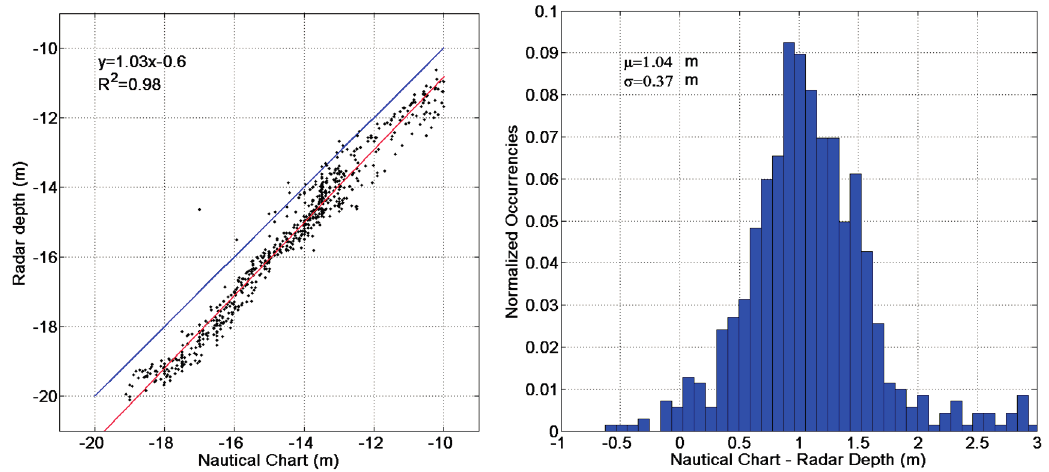
Figure 8. ( Left ) Radar depth vs. echo-sounder measurements. The red line denotes the regression line, whose equation is given in the left top side; ( Right ) Histogram of differences between the radar depth and echo-sounder measurements. The mean value (µ) and the standard deviation ( σ ) of the differences are given on the left top side.